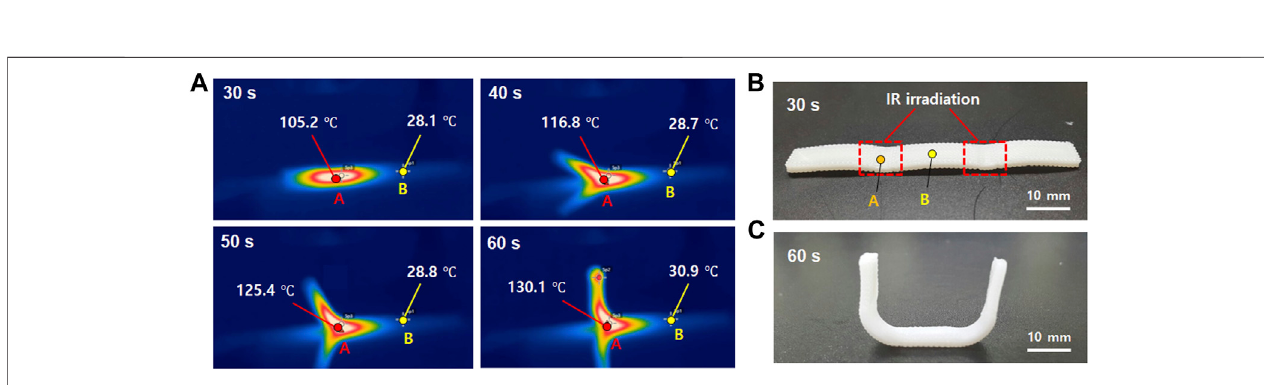
FIGURE 4 | Local shape transformations of a bilayer bar (A) Temperature change with increasing IR irradiation time (B) Deformed shape after 30 s heating (C) Deformed shape after 60 s heating. Here, points A and B indicate the unmasked and masked locations for IR irradiation, respectively.